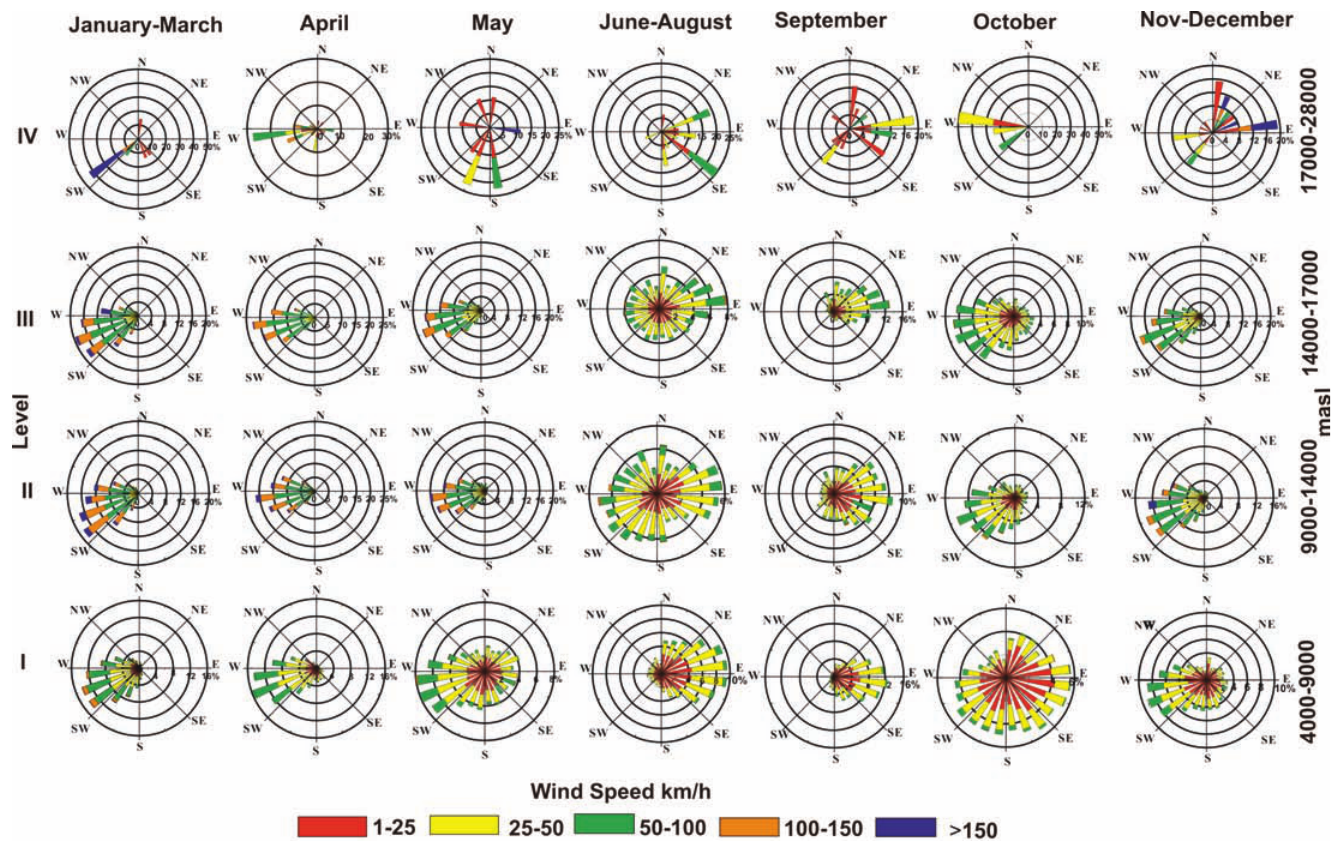
Figure 3. Monthly wind directions for altitudinal levels, based on radiosonde data (1990-2005) from the Manzanillo Station. Wind direction frequency diagrams showing average percentage of time that winds blow towards sectors centered on 4